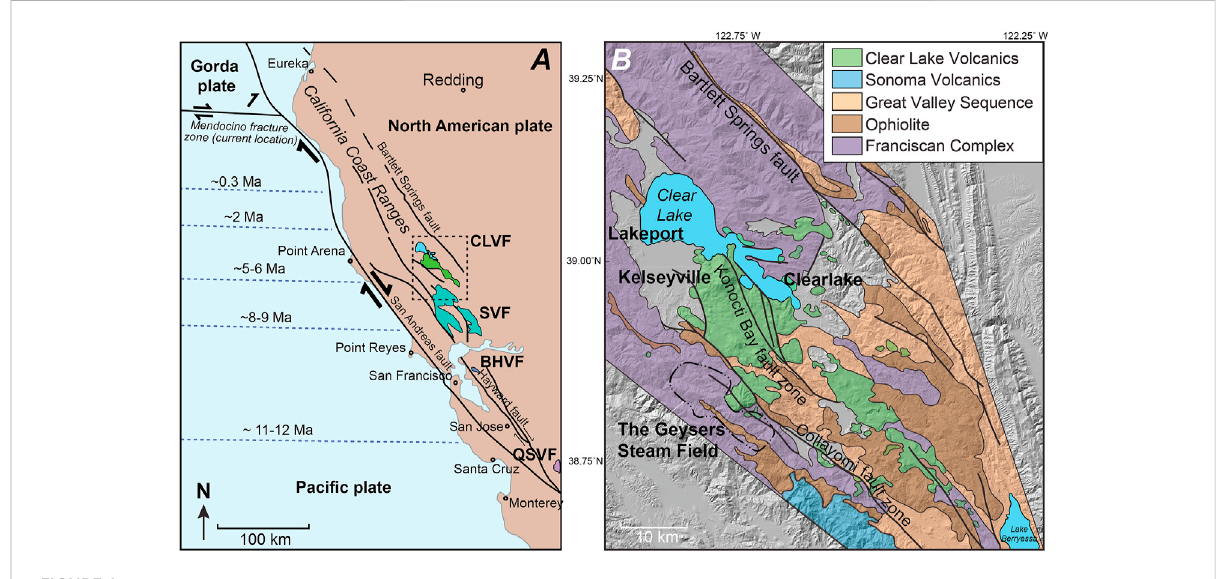
FIGURE 1 (A) Schematic map of northern California, showing the Coast Range volcanic centers, major regional faults, and approximate position of the Mendocino triple junction over the past 12 million years. CLVF = Clear Lake Volcanic Field, SVF = Sonoma Volcanic Field, BHVF = Berkeley Hills Volcanic Field, QSVF = Quien Sabe Volcanic Field. Modi fi ed from McLaughlin and Ohlin (1984); Stanley and Rodriguez (1995). (B) Summary geologic mapoftheClearLakeVolcanicFieldandsurroundingareas,includingarealextentoftheClearLakeVolcanics(green),SonomaVolcanics(blue), Great Valley Sequence sedimentary rocks (peach), ophiolite (brown), and Franciscan Complex (purple). Modi fi ed from Rytuba et al. (2009). Terrain from National Map 3D Elevation Program (3DEP), USGS Earth Resources Observation and Science (EROS) Center, GMTED 2010 March